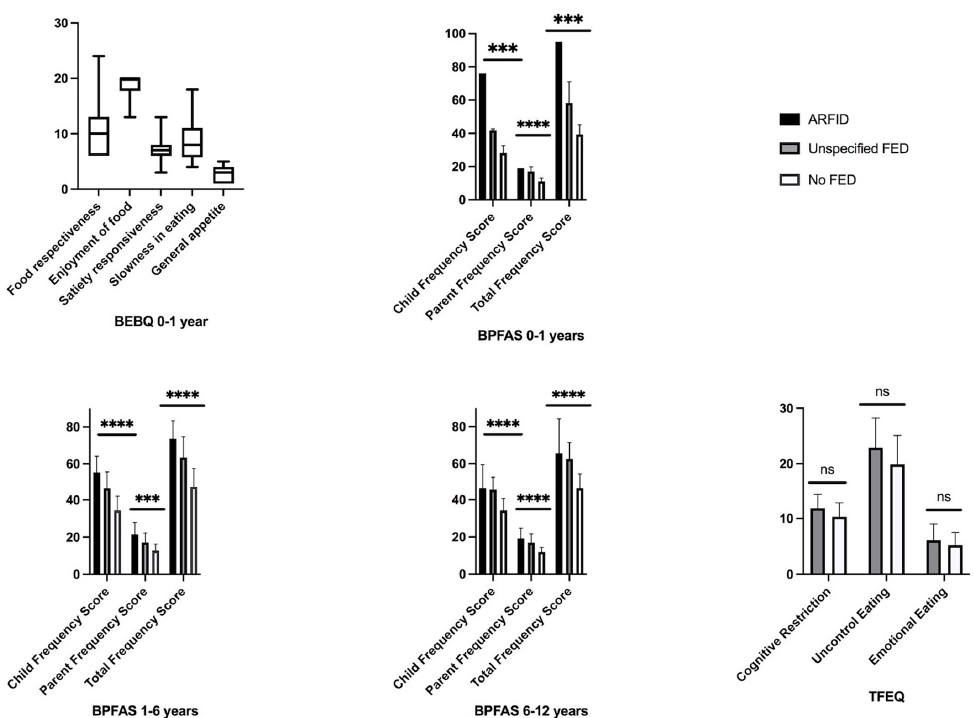
Figure 2. Means of BEBQ (baby eating behavior questionnaire), BPFAS (Behavioral Pediatrics Feeding Assessment Scale) and TFEQ-R18 (Three-Factor Eating Questionnaire) scores (±standard deviation) according to the age and DSM-5 classification of the patients (*** p < 0.001, **** p < 0.0001, Student’s t-test).